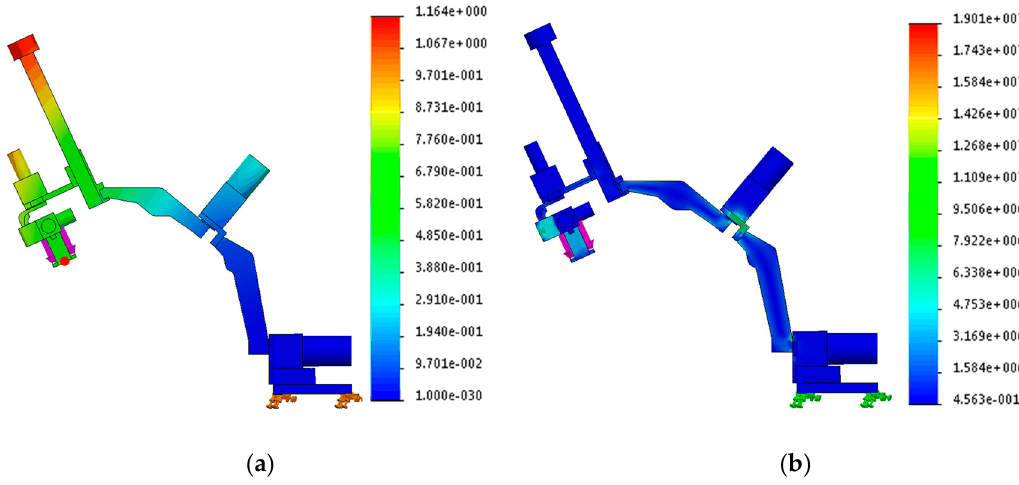
Figure 3. ( a ) Result of deflection. The deflection at the red point is 0.664 mm and ( b ) Result of stress distribution. The maximum stress distribution is 1.901 × 10 7 N/m 2 .